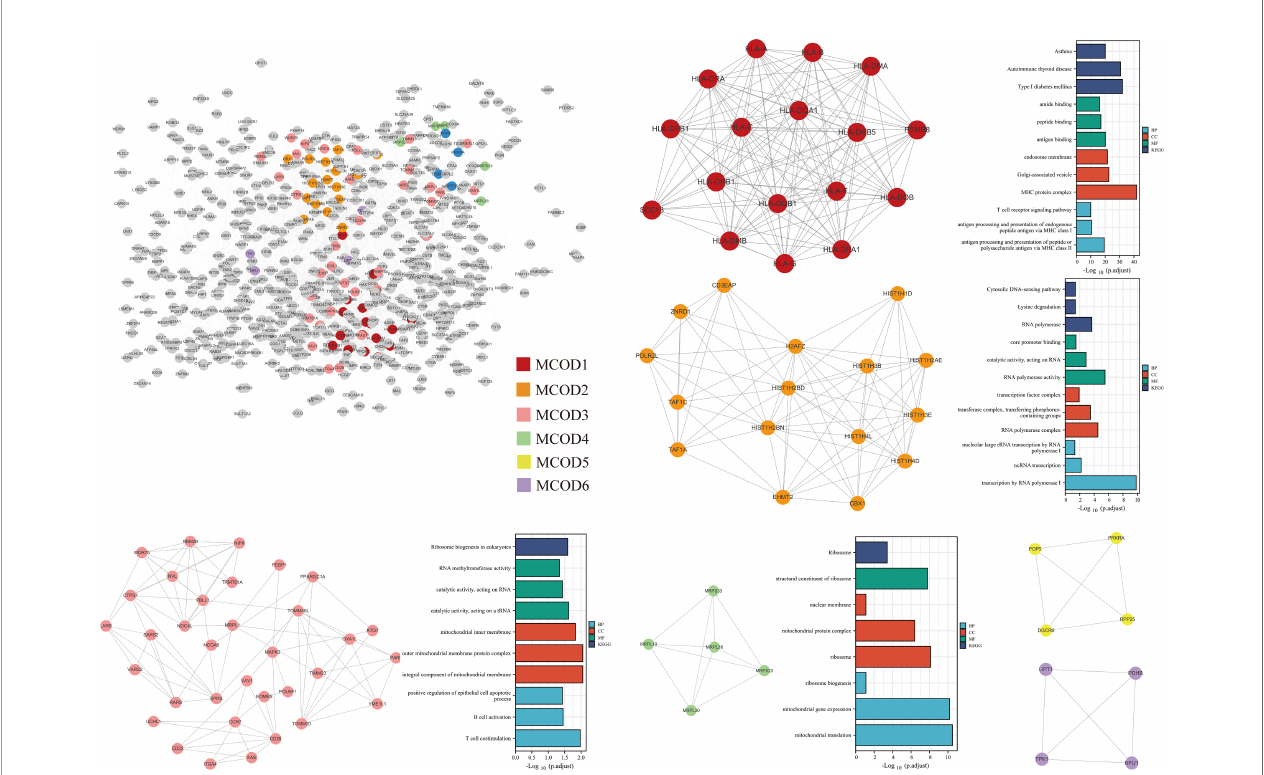
FIGURE 6 | PPI network of the TWAS-identi fi ed genes and their functional